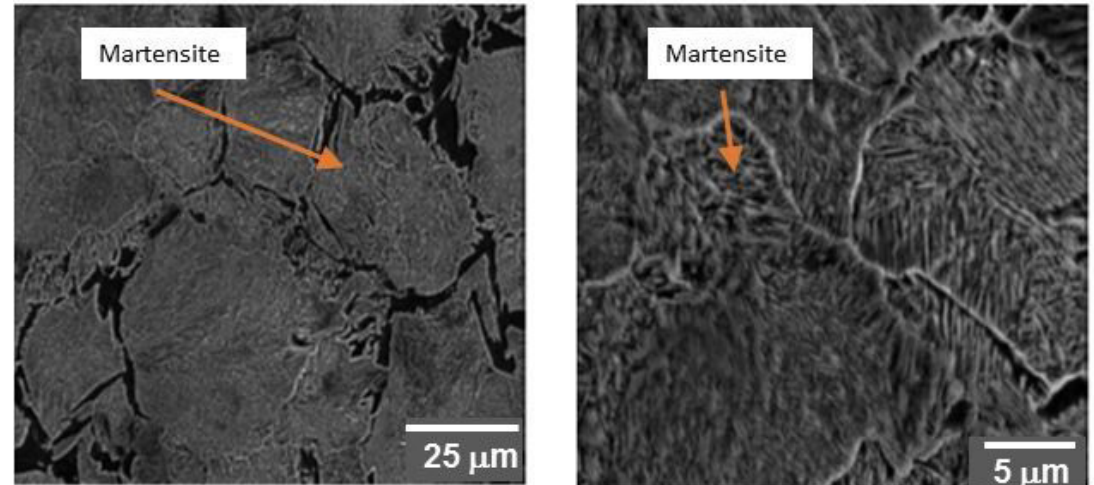
Figure 15. Microstructure of 1035 steel deformed at 785°C, 1000X and 4000X, strain rate 10 -3 s -1 .